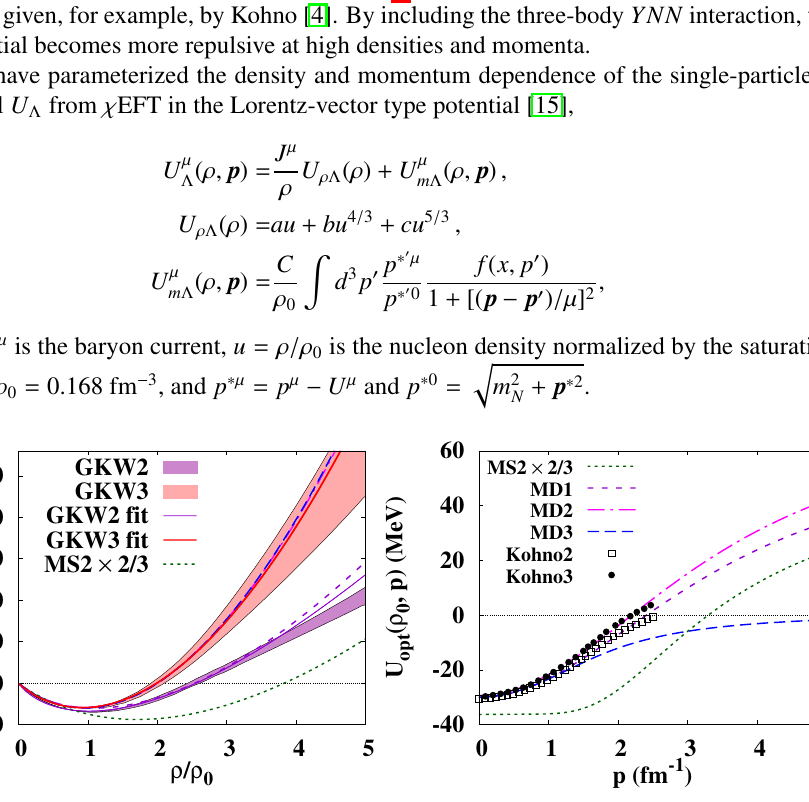
Figure 1. Baryon-density (left) and momentum (right) dependence of the single-particle potentials for Λ . GKW2 and GKW3 represent the Λ single-particle potential from χ EFT with 2- and 2 + 3-body interactions [3]. MS2 × 2 / 3 shows the nucleon single-particle potential multiplied by 2 / 3. MD1, MD2, and MD3 are momentum-dependent potentials obtained by fitting the χ EFT results